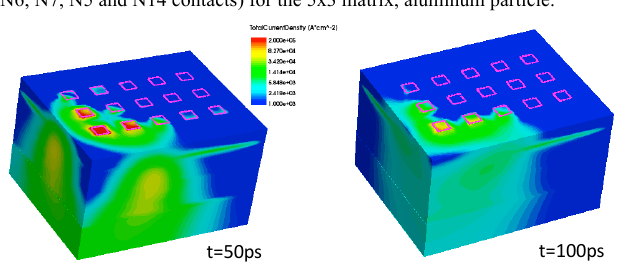
Fig. 10. Comparison of the currents of the six highest currents (N10, N15, N6, N7, N5 and N14 contacts) for the 5x3 matrix, aluminum particle.